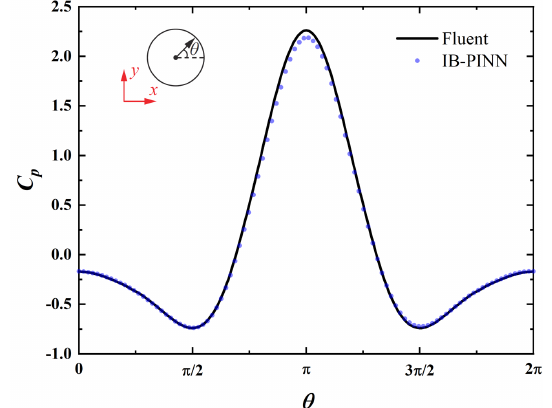
Figure 9. A comparison between the distributions of the pressure coefficient along the cylinder surface obtained using Fluent and IB-PINN. The pressure coefficient is defined as C p = p ρ U 2 max =